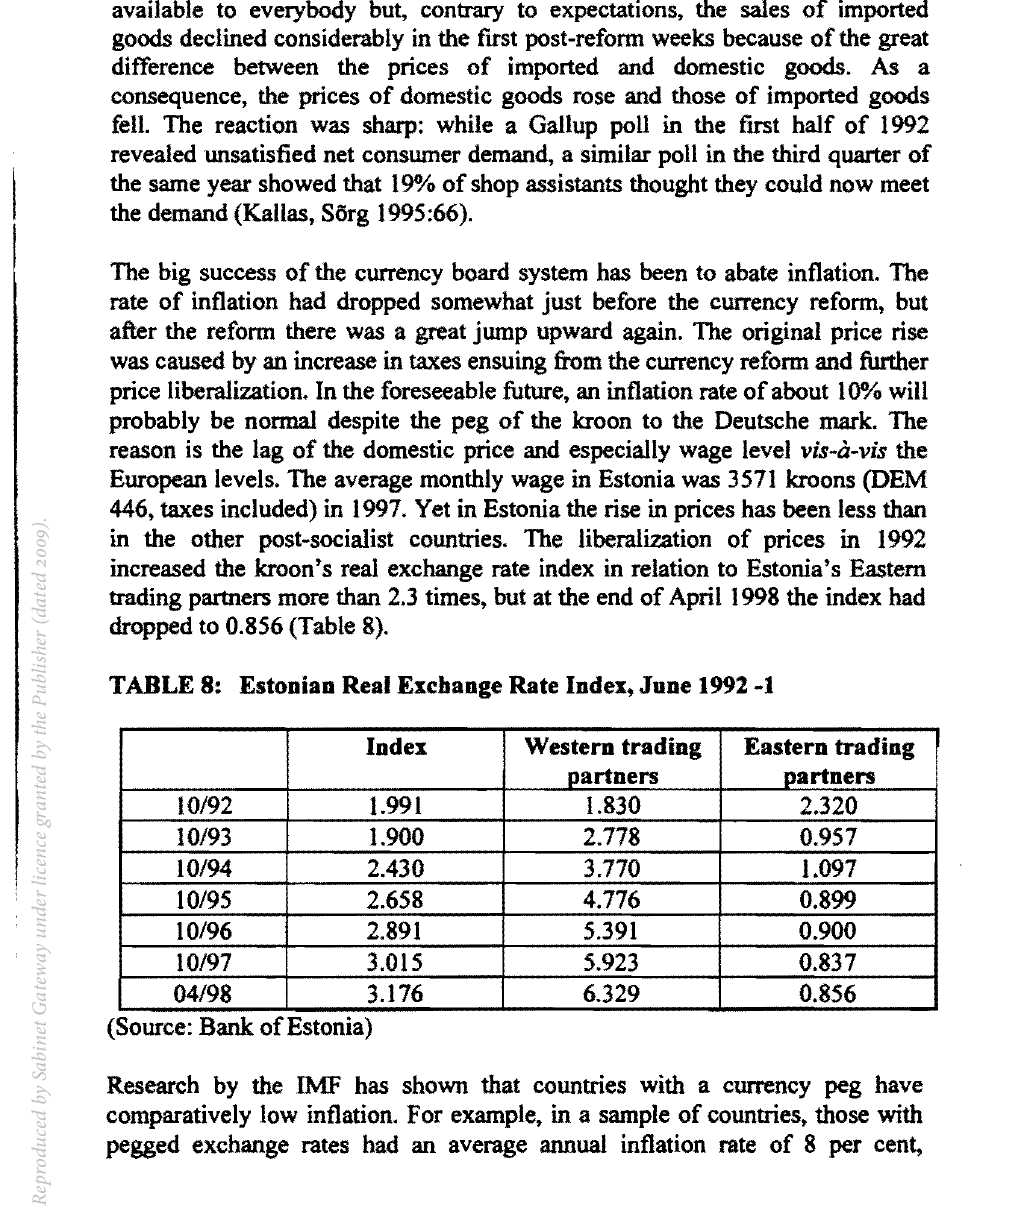
TABLE 8: Estonian Real Excbange Rate Index, June